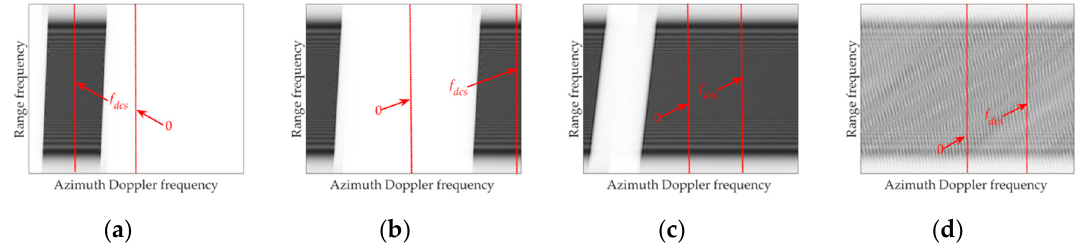
Figure 5. Simulated 2-D spectrum with different PRF for one moving target: ( a ) PRF = 17,000 Hz; ( b ) PRF = 13,000 Hz; ( c ) PRF = 6000 Hz; and ( d ) PRF = 800 Hz.